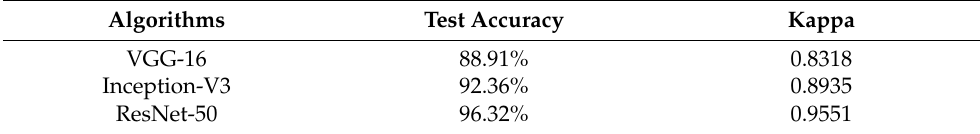
Figure 14. Accuracy and loss for the training and test sets of the three algorithms through multispectral images. Table 4. Performance of the three algorithms for the test sets of multispectral